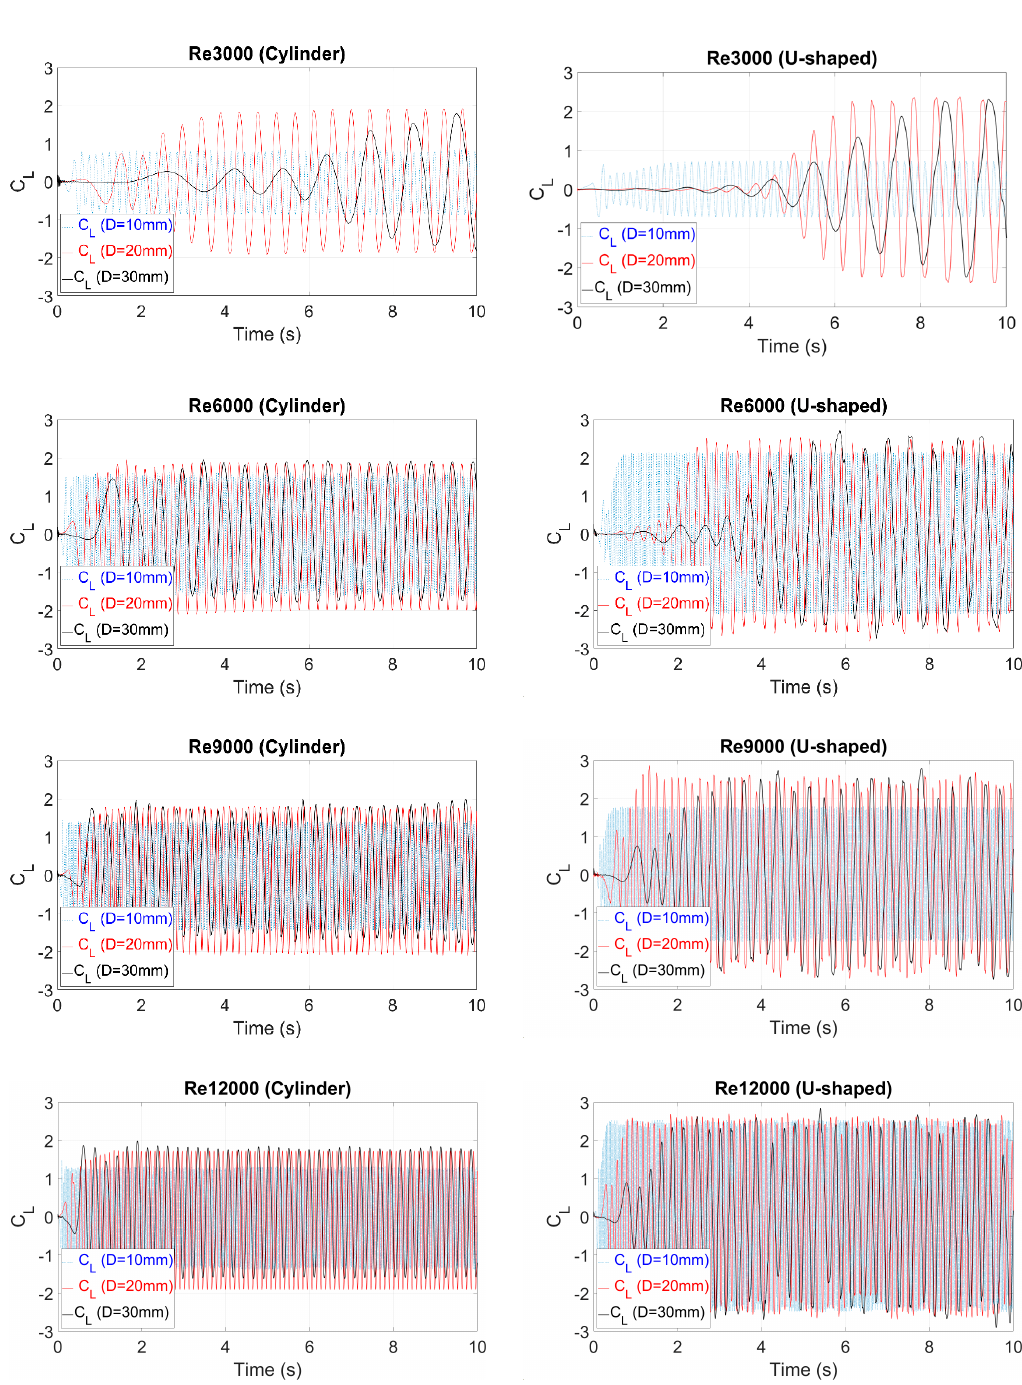
Figure 8. Evolution of the lift coefficient (C L ) for the circular cylinder and U-shaped geometries at each Reynolds number.